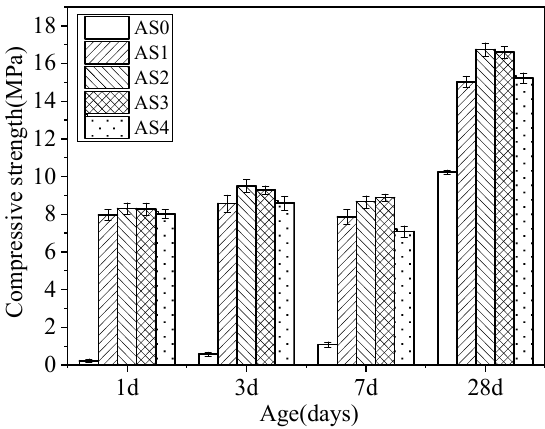
Figure 3. Effect of aluminum sulfate on the compressive strength at different ages.